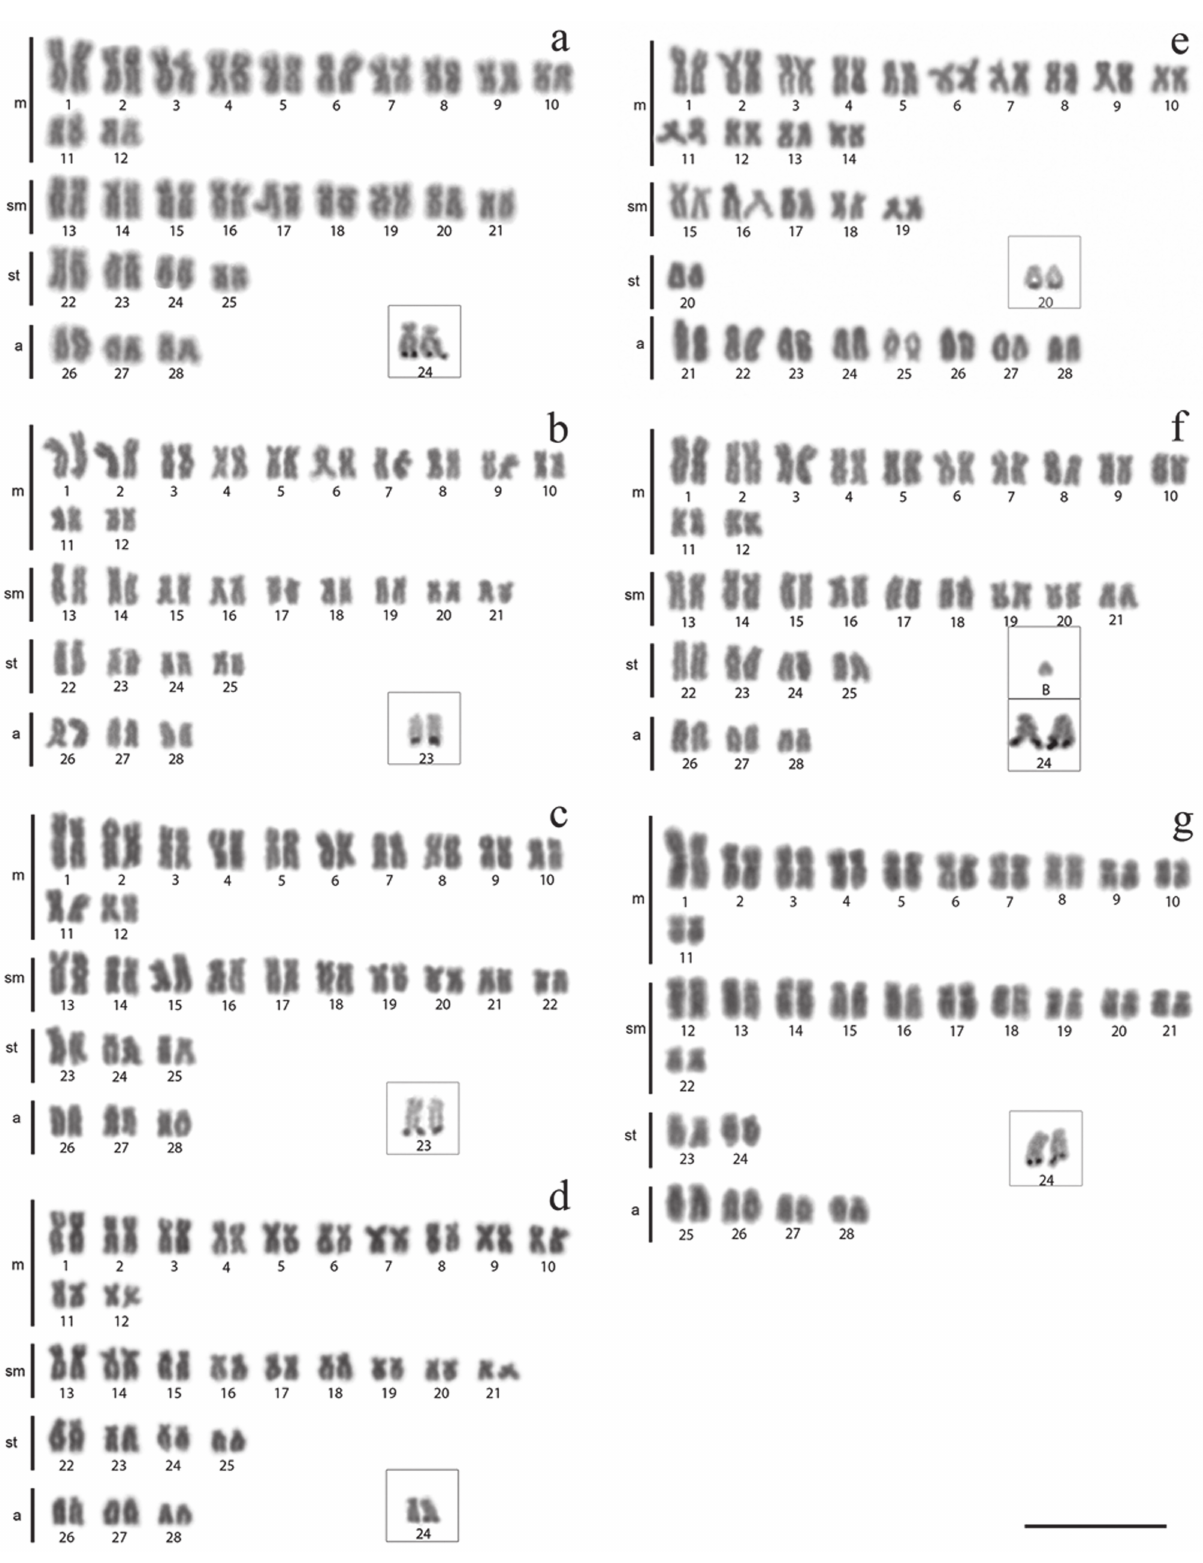
Fig. 1. Karyotypes arranged from Giemsa-stained chromosomes. a. Pimelodus absconditus ; b. Pimelodus britskii ; c. Pimelodus maculatus ; d. Pimelodus microstoma ; e. Pimelodus mysteriosus ; f. Pimelodus ortmanni ; g. Pimelodus paranaensis . Pairs of the AgNORs and B chromosomes are in the boxes. Scales bar = 10